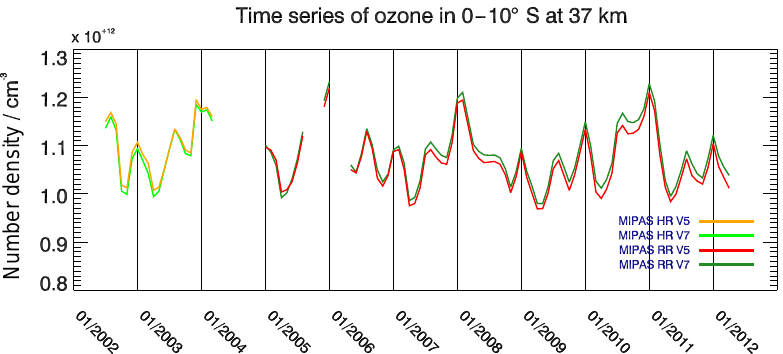
Figure 9. MIPAS time series in the 0–10 ◦ S latitude band at 37km. Drift has an approximately linear structure, which is indirect evidence that the methods of estimating MIPAS drift, chosen in Eckert et al. (2014), are